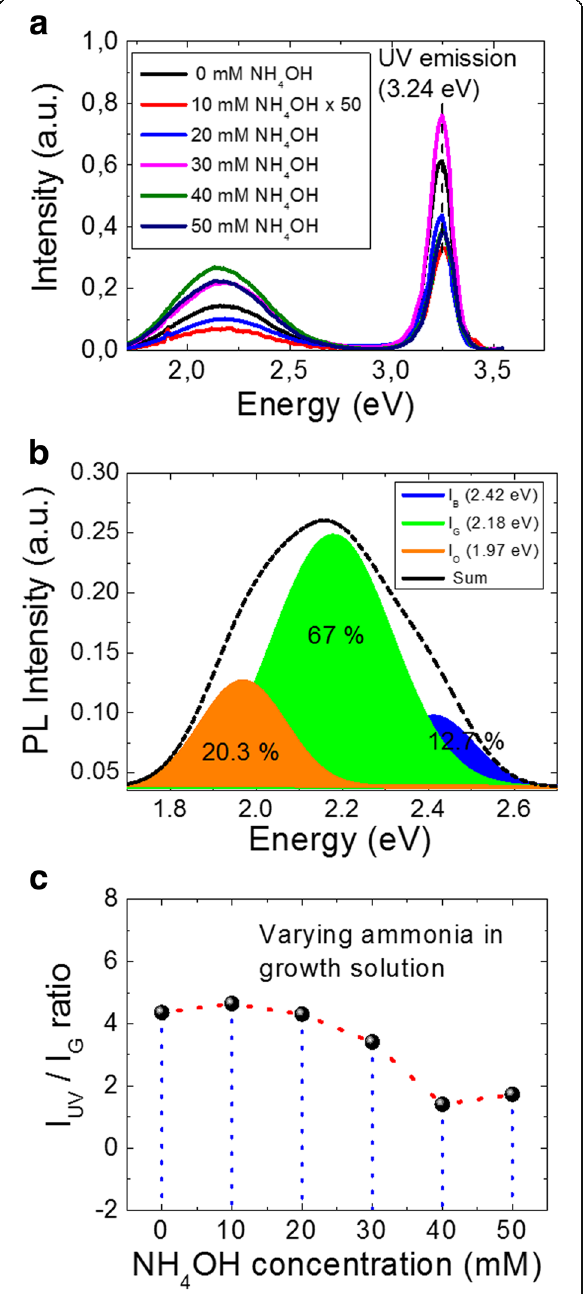
Fig. 2 The PL measurements results. a The PL spectra of the ZnO NWs grown under different ammonium hydroxide concentrations. b Deconvoluted Gaussian fit for the 40-mM sample to blue, green, and orange emission states and their percentage contributions in visible emission. c The intensity ratio of UV and green emission peak as a function of NH 4 OH